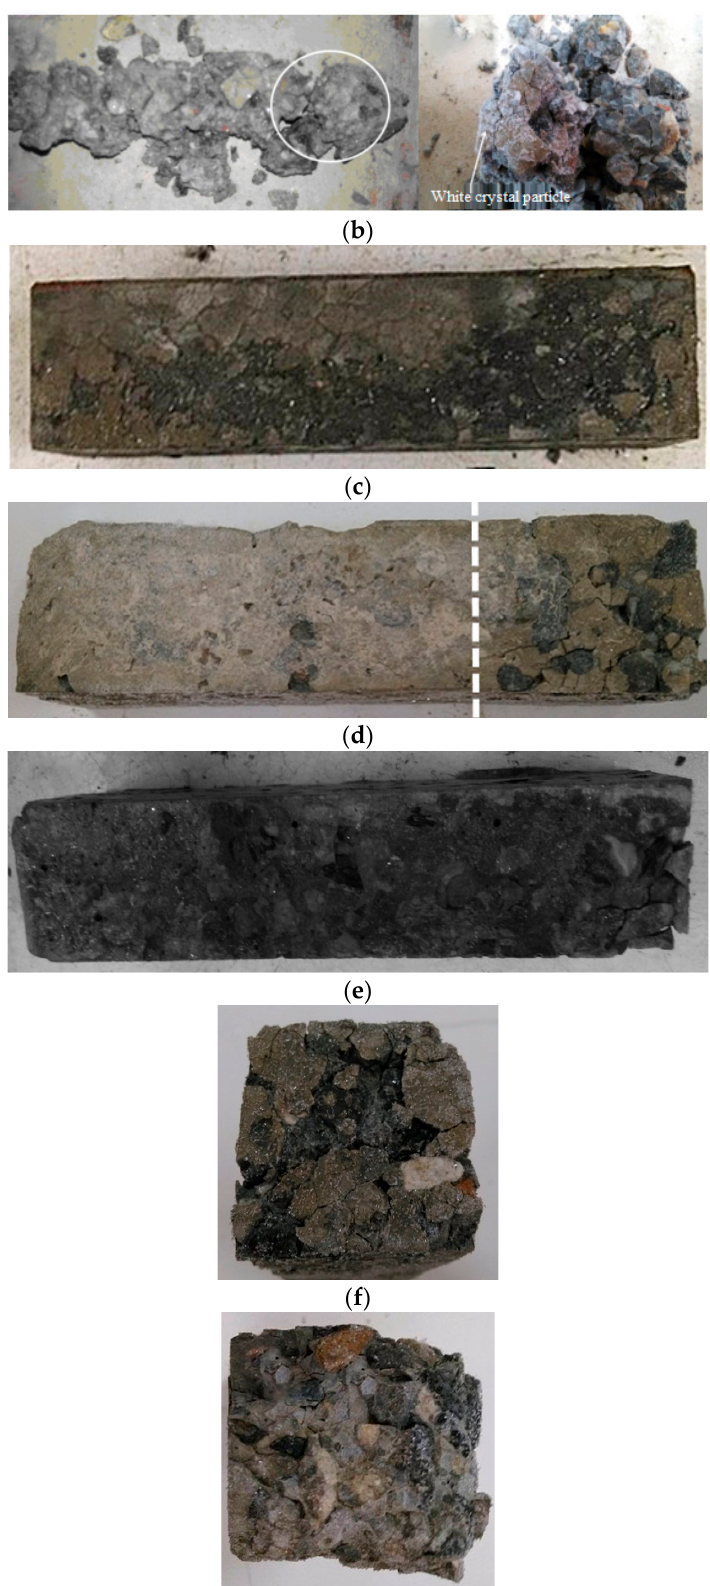
Figure 2. The samples added with different admixtures. After 300 dry–wet cycles of sulfate treatment. ( a ): OPC; ( b ): QP20; ( c ): SG20; ( d ): SG30; ( e ): QP10SG20; ( f ): FA10; ( g ): QP10FA20.